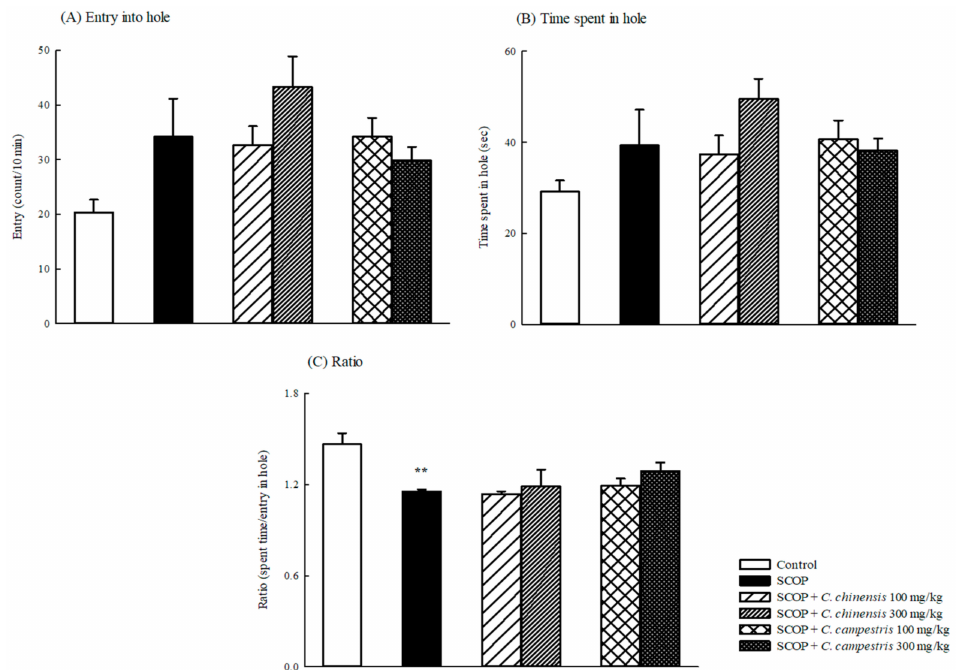
Figure 2. The effects of Cuscuta chinensis and C. campestris extracts (100 and 300 mg/kg, po) on ( A ) entries into hole, ( B ) time spent in hole, and ( C ) ratio of the time spent to the entry number in scopolamine (SCOP, 1 mg/kg, ip)-treated mice. Columns indicate mean ± SEM ( n = 7). ** p < 0.01 compared with the control